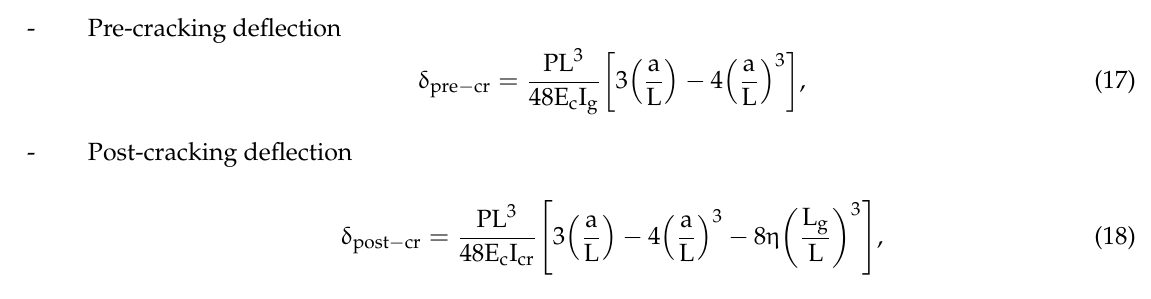
Bending moment (kNm) = Applied load (kN) · a / 2 ( a = 1 m)